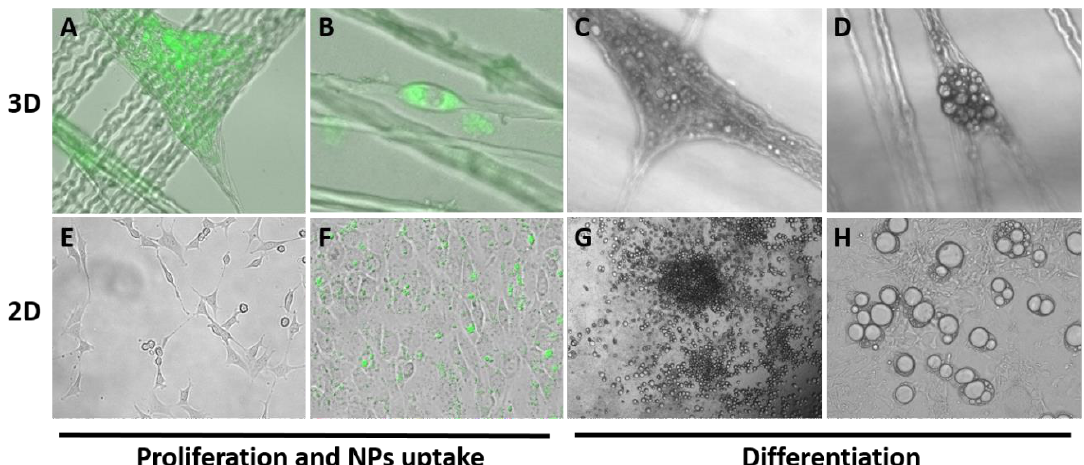
Figure 4. NPs uptake and adipogenic di ff erentiation of cells cultured in collagen-alginate biocomposite. Cells cultured in 3D biocomposite labeled by green fluorescence after Si NPs-FITC conjugated uptake (magnification × 200 and zoom out × 400, A , B ). Adipogenic di ff erentiation of cells cultured on the biocomposite ( C , D ). Cells migrated through the biocomposite to reach the culture dish (2D). These cells grew well and were able to take up NPs (magnification × 200 and × 400, E , F ) and continue with adipogenic di ff erentiation (magnification × 40 and × 200, G , H ).